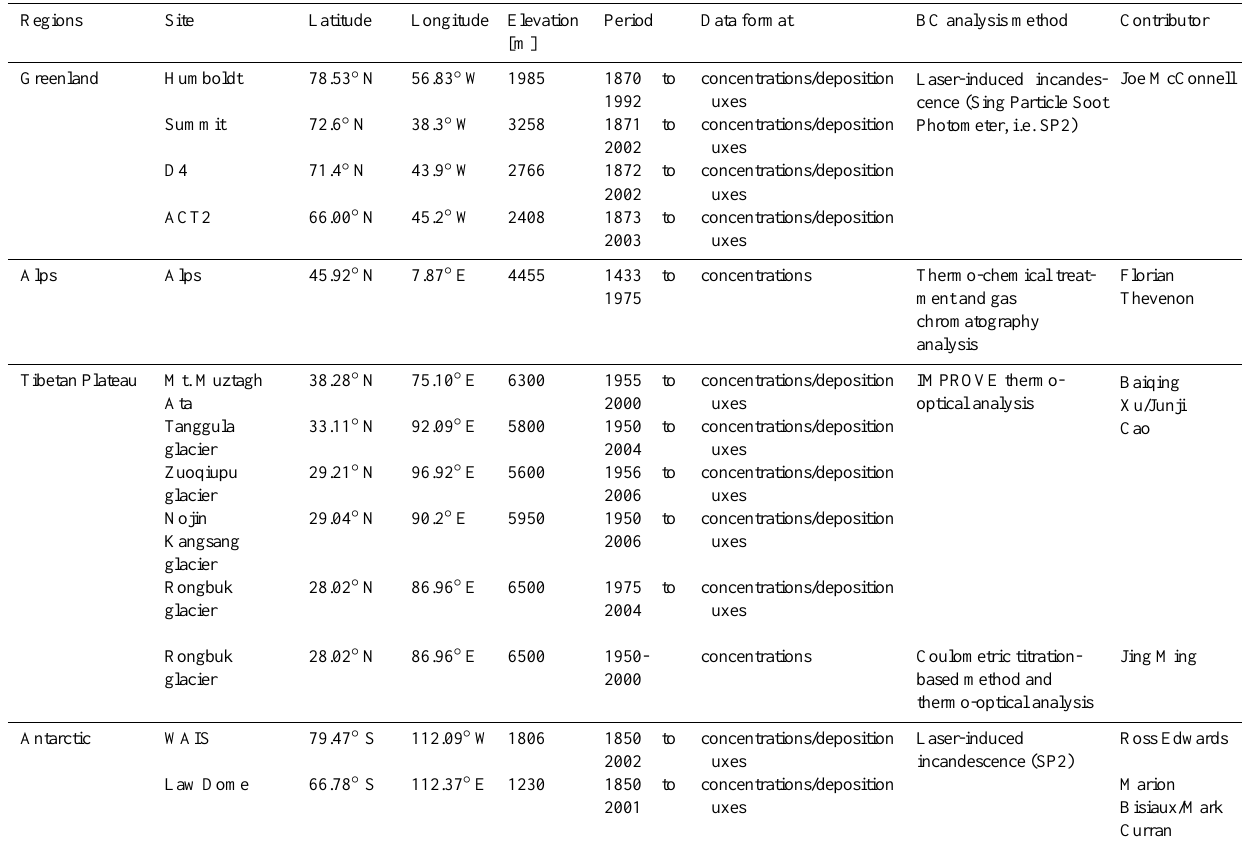
Table 7. List of the ice core observation sites used in this study.